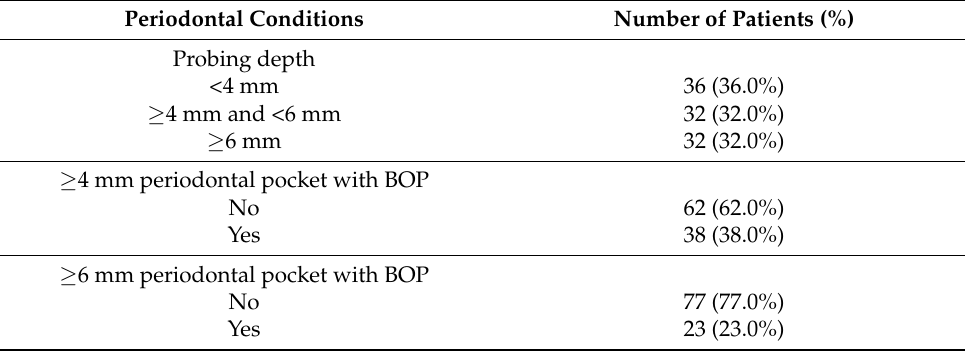
Table 1. Periodontal conditions in older people. Periodontal